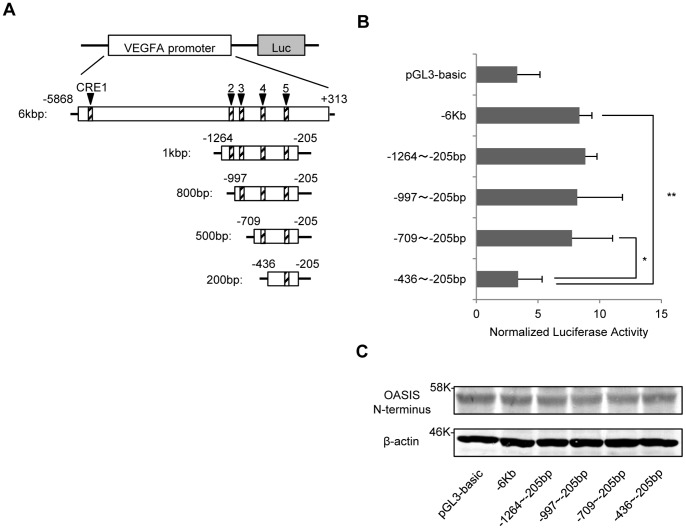
OASIS modulates VEGFA promoter activities via the region between –709 and –437 bp.(A) Schematic diagrams of the deleted reporter constructs from the 6-kbp 5′-upstream promoter of the human VEGFA gene. Five putative CRE-like sites (containing an ACGT core) exist in the 6-kbp VEGFA promoter region. (B) Reporter assays using ARPE-19 cells. Each deletion reporter vector and the OASIS N-terminus expression vector were co-transfected. Reporter assays were performed at 48 h after the transfection. Note that reporter activities significantly decreased in cells transfected with the 200-bp construct, suggesting that OASIS acts on a site in the region between –709 and –437 bp of the VEGFA promoter. Data are means ± SD (n = 6). *p<0.05, **p<0.01, by Student’s t-test. (C) Western blot analysis shows the FLAG-tagged OASIS N-terminus was expressed at equal levels in each sample.